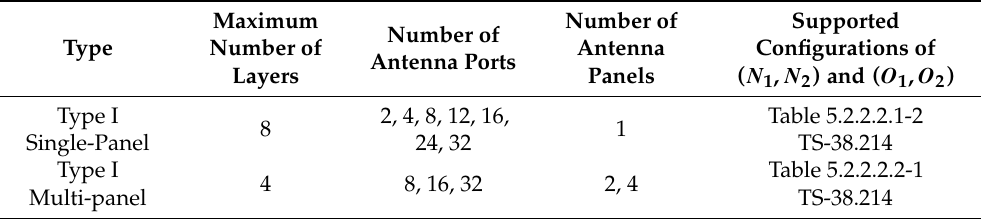
Table 1. Supported parameters by Type I downlink codebook-based transmission.